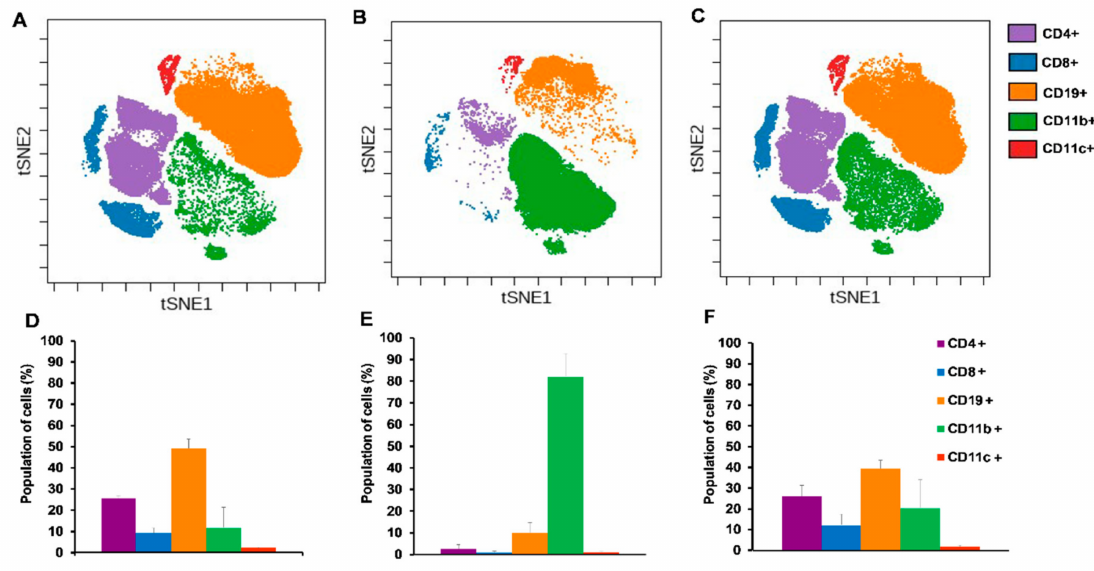
Figure 4. Single cell mass cytometric immunophenotyping showed the accumulation of CD11b + myeloid cells in 4T1 tumor bearing animals at the expense of lymphoid subsets which was reverted by cisplatin treatment. The visualization of stochastic neighbor embedding (viSNE) analysis was run on the ( A ) naive, ( B ) 4T1 tumor bearing, and ( C ) cisplatin treated 4T1 tumorous animals within the CD45 + living singlets. Quantitative analysis of the main lymphoid subsets: CD4 + T-cells = lilac, CD8 + T-cells = blue, CD19 + B-cells = orange and the myeloid CD11b + = green, CD11c + = red subsets were performed in the spleen of ( D ) naive, ( E ) 4T1 tumor bearing, and ( F ) cisplatin treated 4T1 tumorous mice within the CD45 + living singlets. Representative viSNE plots and column bars are shown from the pooled samples of 6 mice per group. Data are shown as arithmetic means on the column bars ± SEM. Pairwise comparison of the emergence of CD11b + population in ( E ) vs. ( D ) and its decrease by cisplatin treatment ( F ) vs. ( E ) has statistical significance at p <